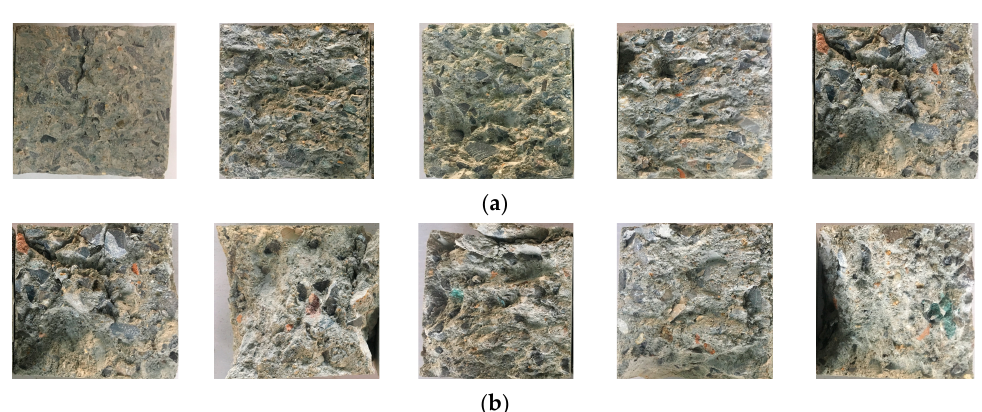
Figure 3. Shear interface failure modes of recycled concrete. ( a ) The influencing factor of recycled aggregate (RA) replacement rate: 0%, 25%, 50%, 75% and 100% (zero axial compression ratio); ( b ) The influencing factor of axial compression ratio: 0, 0.138, 0.207, 0.276 and 0.414 (100% RA replacement rate).